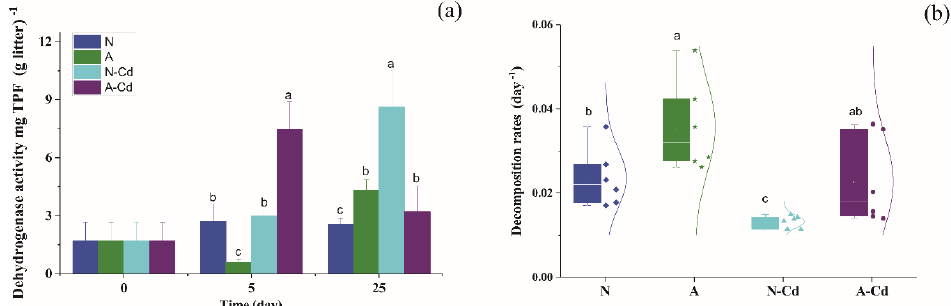
Figure 5. Decomposition rate of Pterocarya stenoptera leaf litter ( a ) and associated dehydrogenase activity ( b ) after 25 days of incubation in the microcosms. Legend: N, natural light simulation group without Cd; A, artificial light at night (ALAN) simulation group without Cd; N-Cd, natural light simulation group with Cd; N-Cd, ALAN simulation group with Cd. Di ff erent lowercase letters on top of the bars denote significant di ff erences ( p < 0.05) among the